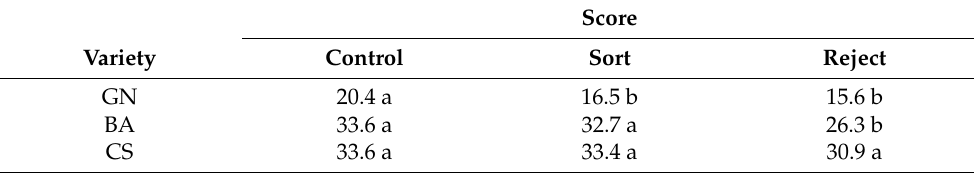
Table 10. Mean color scores from sensory analysis. Judges were instructed to match wine colors to colors on a poster (Les Couleurs Du Vin, Bouchard Aîn é & Fils). Higher scores corresponded to darker colors.